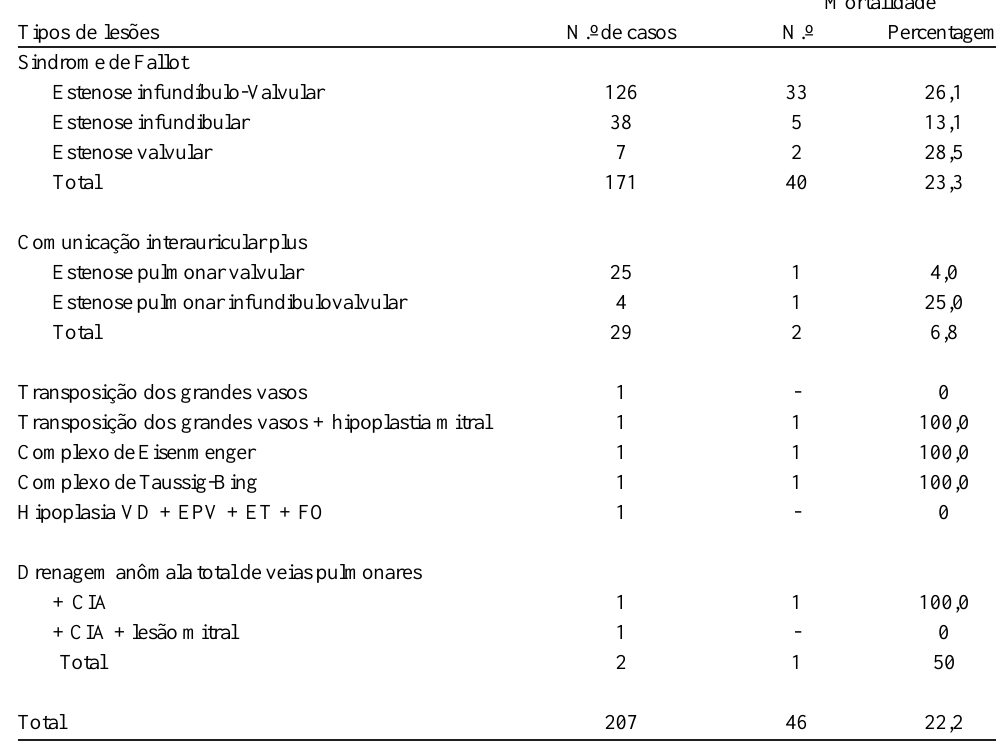
Tabela 3. Cardiopatias congênitas cianóticas (207